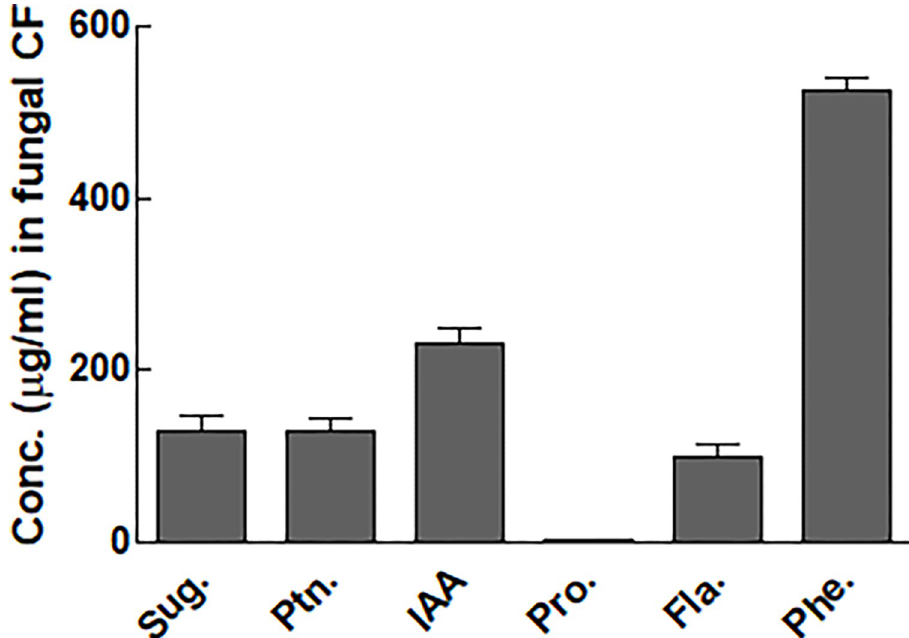
Fig 3. Concentration of total soluble sugar, proteins and secondary metabolites produced by Ch-06 in Czapek broth media. The data reflect the mean of triplicated data followed by ± SE. The data with different superscript letter are significantly different at P =